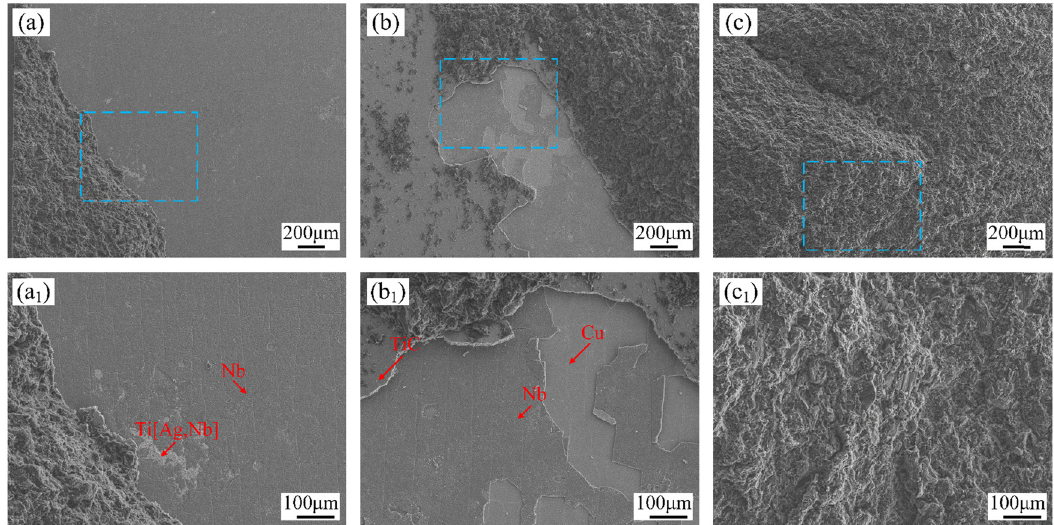
Figure 6: The fractography of the graphite/Cu joints at 850°C: ( a ) 30 min, ( b ) 60 min, ( c ) 90 min; ( a 1 – c 1 ) : enlarged view of the blue box in ( a – c )